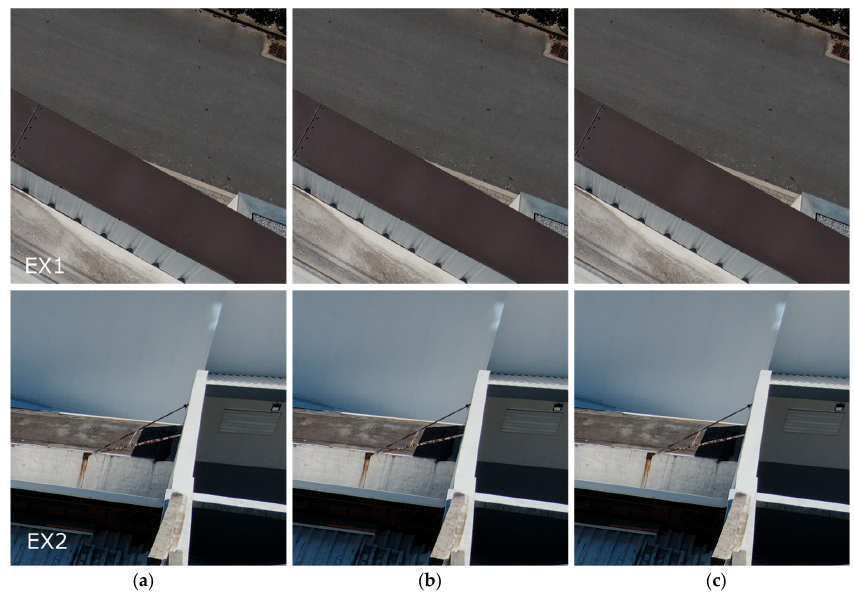
Figure 18. Examples of no classification in the presence of corrosion outside the area of the roofing system (EX1 and EX2): ( a ) original image, ( b ) ground truth, and ( c ) prediction.